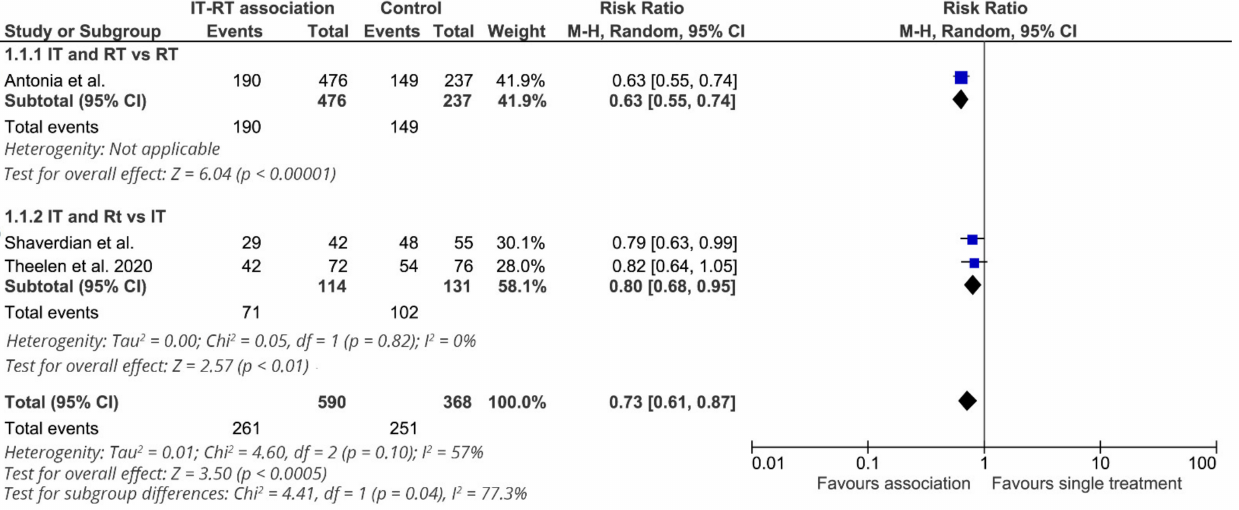
Figure 5. 1-year progression-free survival. Meta-analysis of 3 studies of ICI-RT association: 1 study of ICI-RT vs. RT alone ( a ) and 2 studies of ICI-RT vs. ICI alone ( b ). The risk ratio (RR) and 95% confidence interval (CI) for the effect of treatment on 1-year progression-free survival are shown on a logarithmic scale. Studies are arranged by publication year. Theelen study is a pooled analysis of two